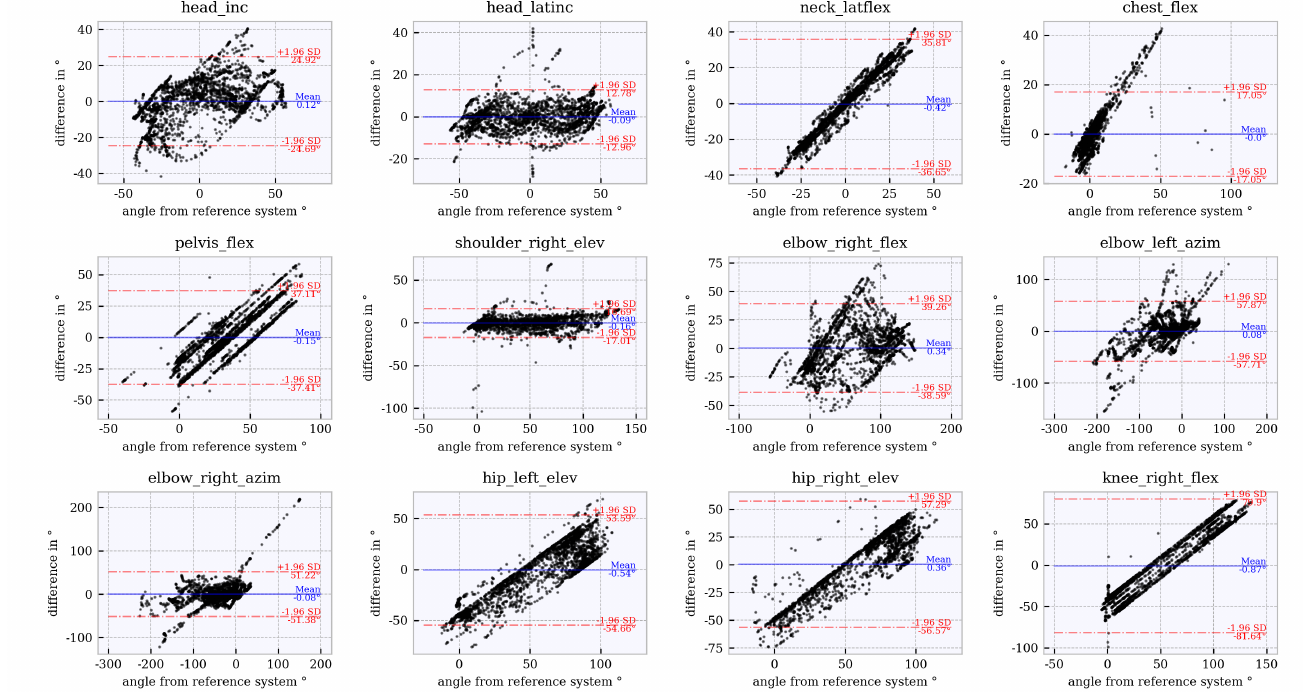
Figure A2. Bland–Altman plot for tracker configuration 4 ; x does not show the average of both systems but the joint angles of the reference system, Qualisys.